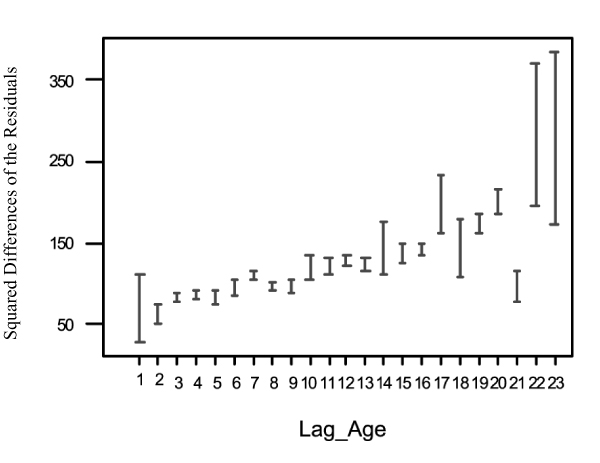
Empirical semi-variogram for real data set from second cohort.